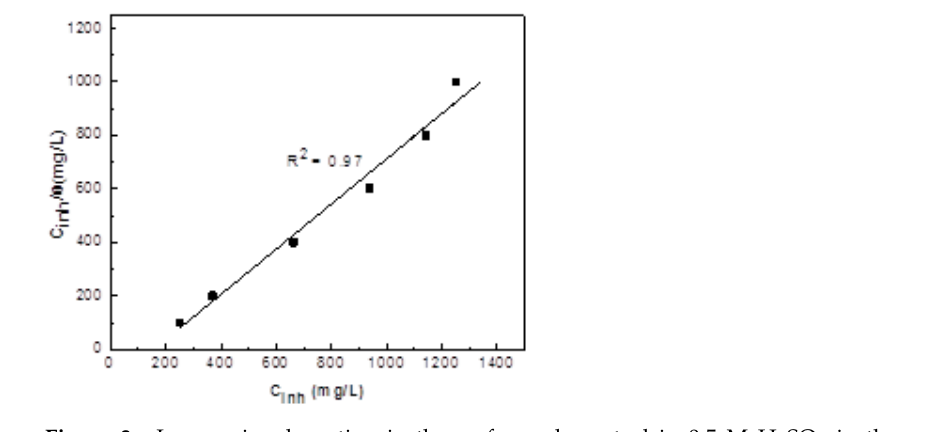
Figure 3. Langmuir adsorption isotherm for carbon steel in 0.5 M H 2 SO 4 in the presence of α -linolenic acid.